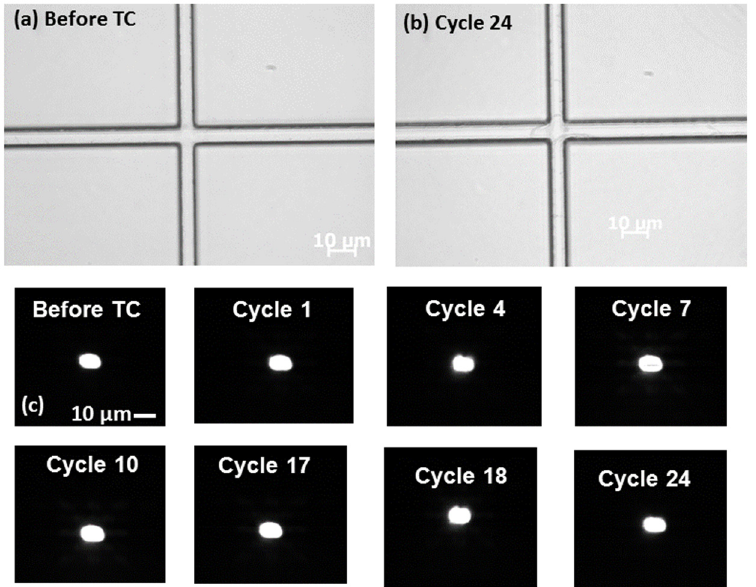
Figure 14. Influence of 24 thermal cycles on TiO 2 –SiO 2 sol-gel waveguides. Microscope observations of a waveguide grid ( a ) before the thermal cycle and ( b ) after 24 cycles. ( c ) Output light observations after injection of white light (supercontinuum) in straight waveguides after several thermal cycles.